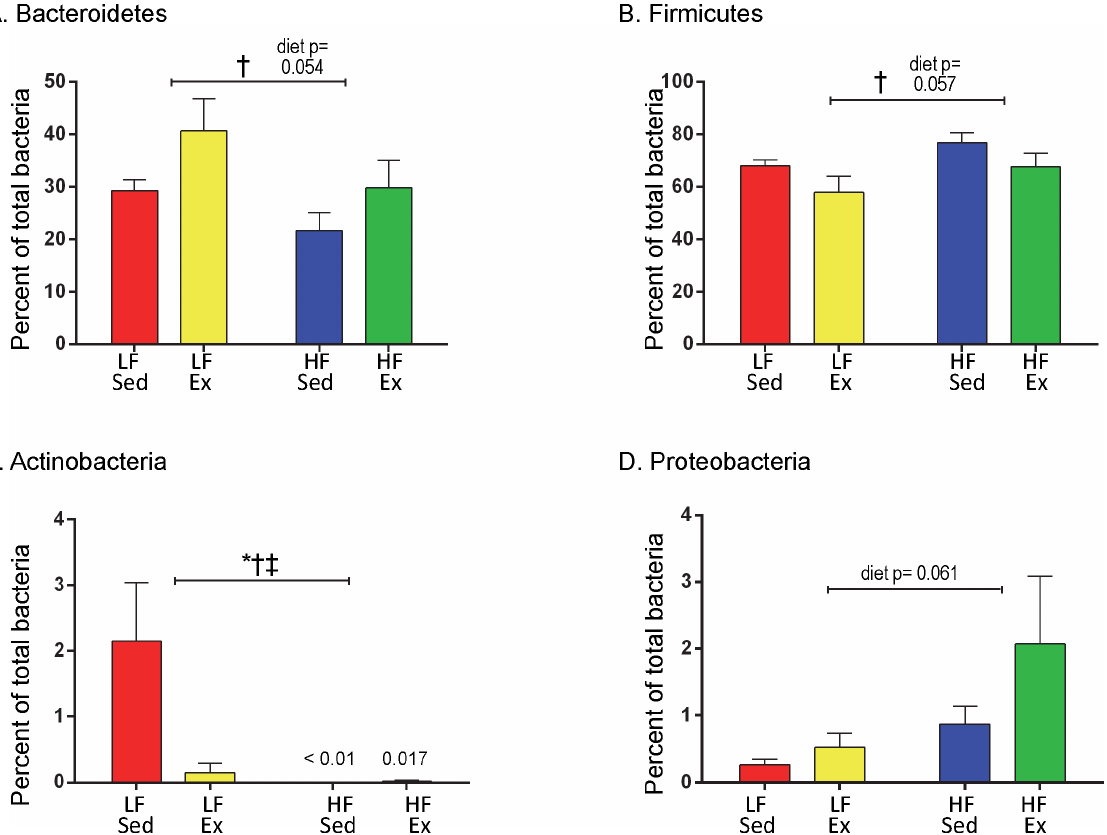
Figure 4. Phylum Level Changes with Diet and Activity. At week 12, diet and activity changed the levels of two major and two minor phyla of bacteria. Data were analyzed by 2-way ANOVA with a Sidak post hoc test. Significant differences indicated as follows: ‘‘*’’ p , 0.05 for diet effect, ‘‘ { ’’ p , 0.05 activity effect and ‘‘ ` ’’ p , 0.05 diet and activity interaction. n=6 mice/group. doi:10.1371/journal.pone.0092193.g004 (r 2 =0.35) based on a Pearson test (Pearson’s r= 2 0.591, p = 0.043).